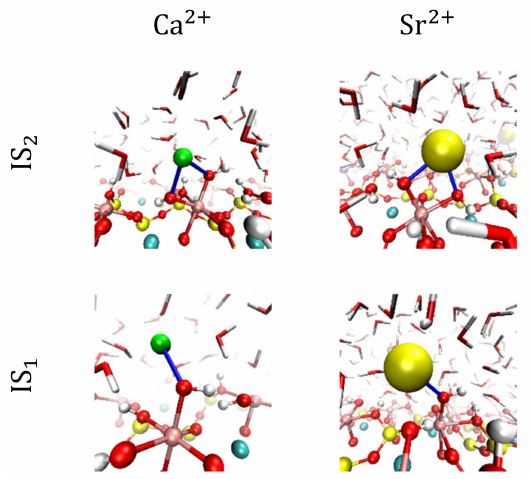
Figure 6. Alkaline-earth metal inner-sphere complexes with one and two adsorption contacts with the negatively charged (110) spodumene surface. Surface charge density is − 0.125 C/m 2 . Ca and Sr atoms are represented by green and yellow spheres, respectively. Contacts are highlighted in